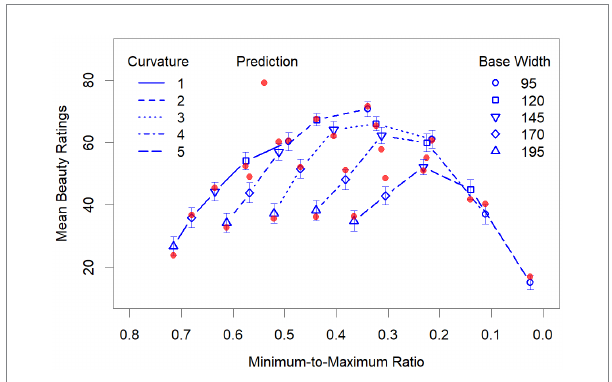
FIGURE 5 Mean beauty ratings as function of the MMR for the different widths and curvatures. The red filled dots represent the prediction by the second regression model (see details in the text). Note that the values of the X-Axis decrease from left to right to make their direction compatible with that in Figure 4.